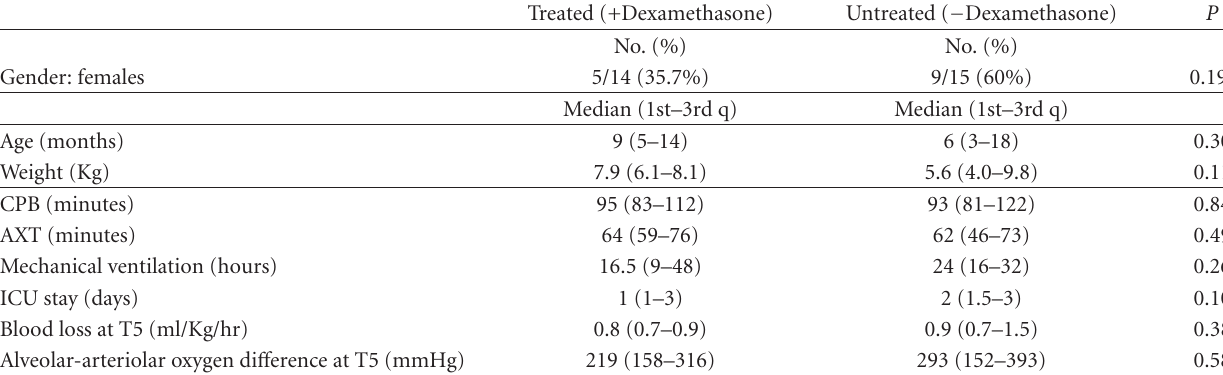
Table 1: Demographic and clinical characteristics of the